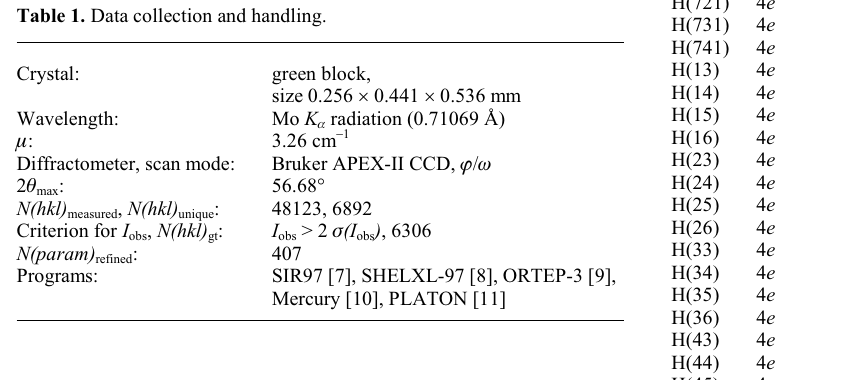
Table 1. Data collection and